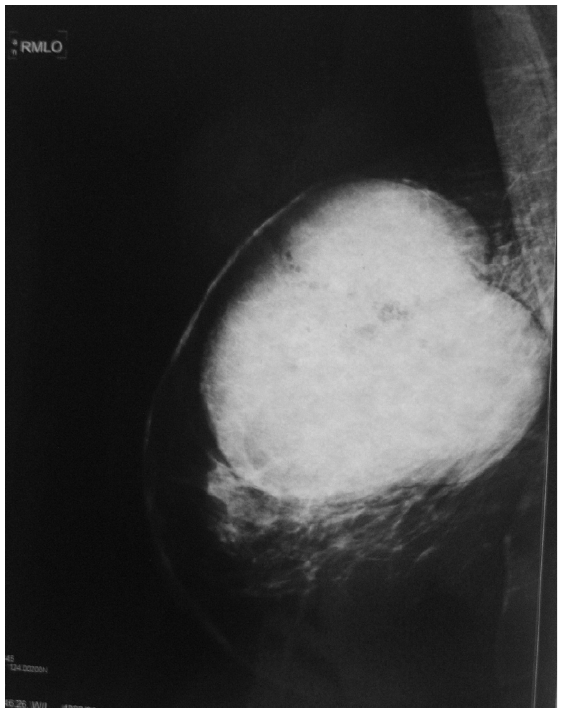
Figure 1. Mammography: a huge tumor mass in the right